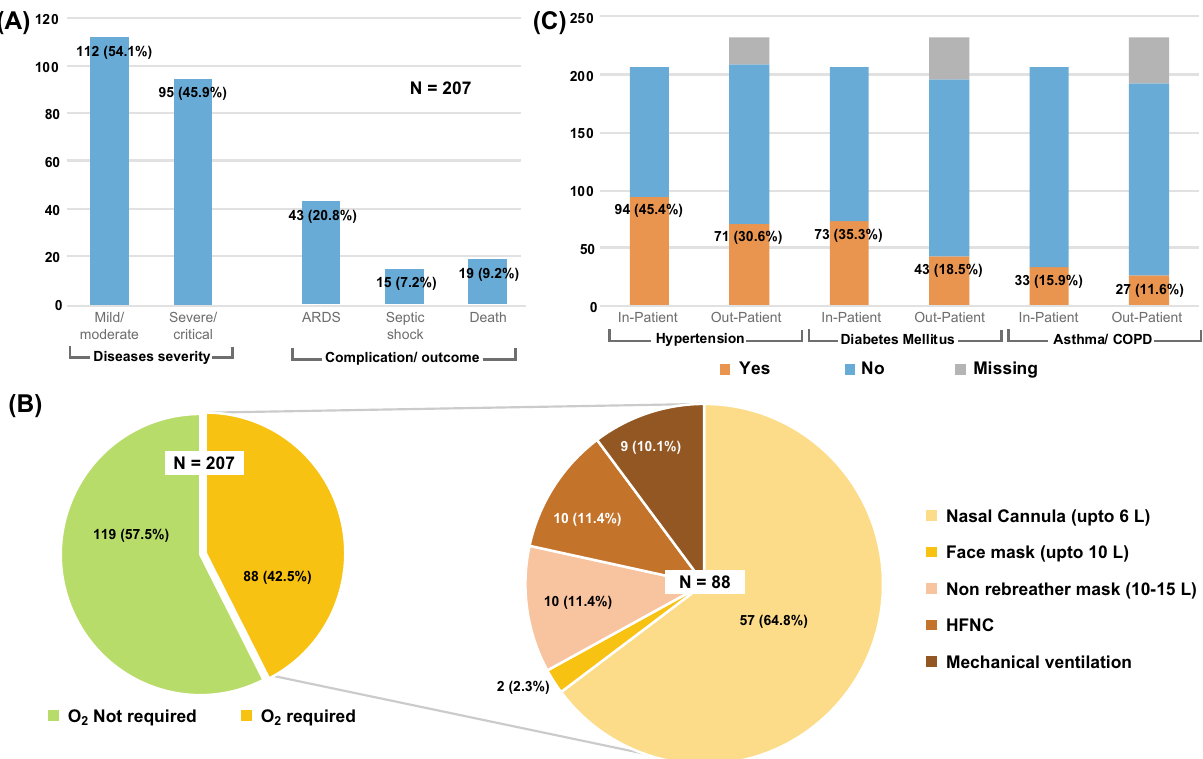
Figure 3. Clinical features of the positive cohort. ( A ) Diseases severity, complication, and outcome of in-patient group. ( B ) Oxygen requirement of in-patient group. ( C ) Comorbidity of COVID-19 positive in-patient (hospitalised, n = 200) and out-patient (not hospitalised but seek treatment in staff clinic, n = 207)